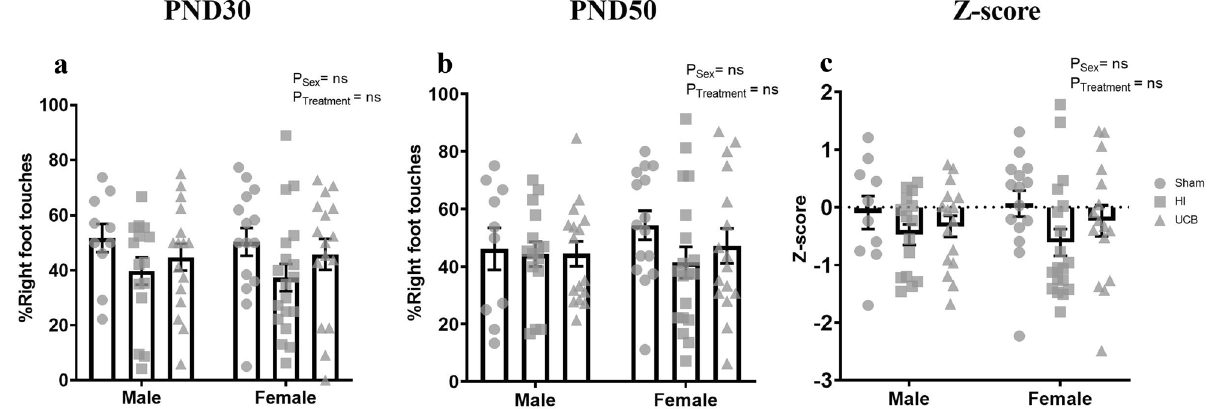
Figure 3. Raw and transformed scores for the cylinder test. The percentage of right foot touches on PND30 ( a ) and PND50 ( b ) was recorded. Raw scores were transformed into a cylinder test Z-score ( c ). A positive Z-score reflects an improvement in behaviour, negative Z-score reflects deficit in behaviour (In these graphs, the sham group is represented by a circle, the HI group is represented by a square and the UCB groups is represented by a triangle. Data expressed as mean ± SEM, n = 10–19 pups per group).